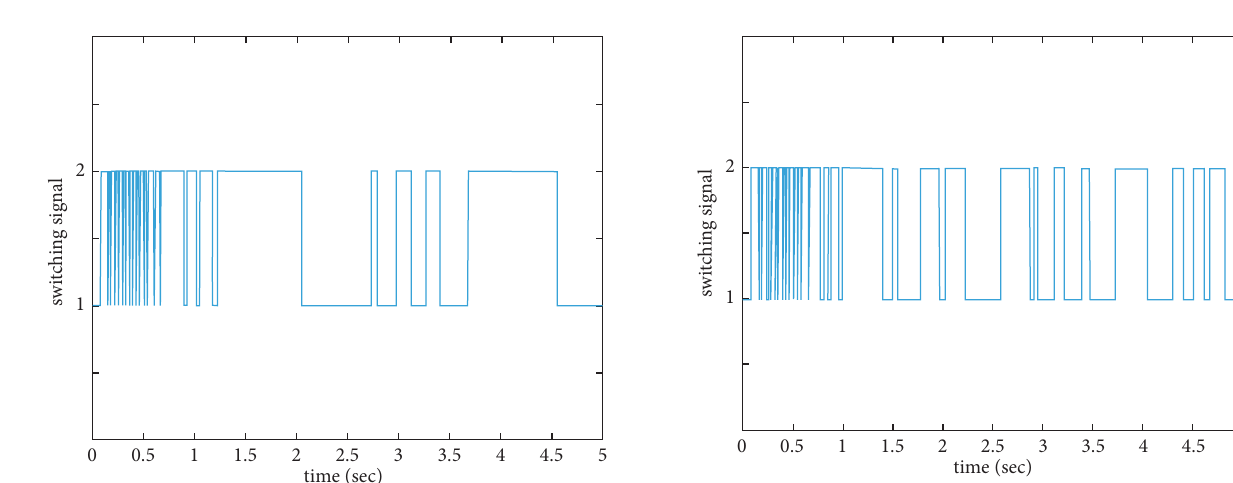
Figure 4: The switching signal of System (35) with a bounded input u ( t ) � cos ( 96 t )